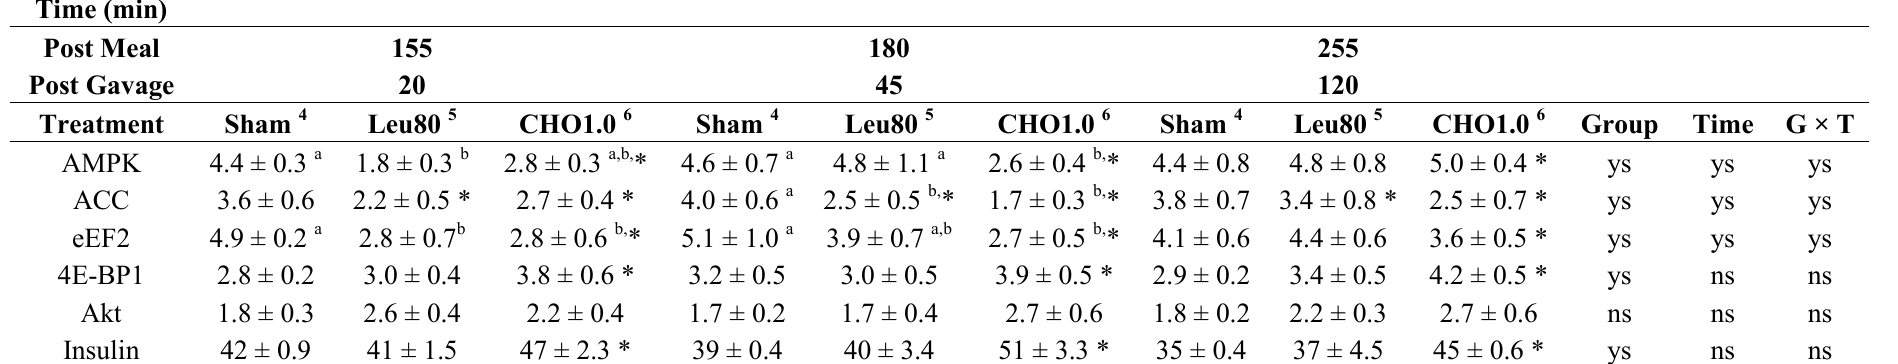
Table 4. Post-gavage signaling 1 and plasma insulin 2 results for Experiment 2 3